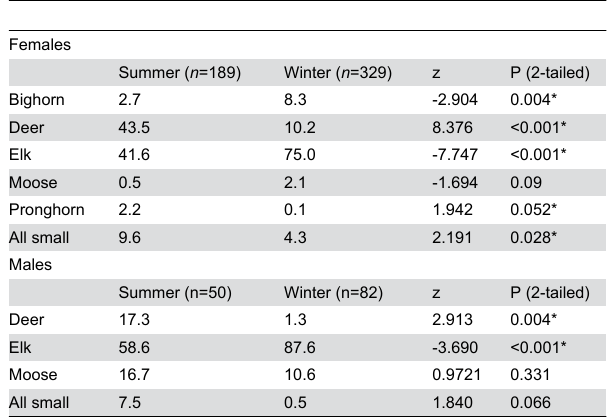
Table 3. A comparison of proportions (%) of different prey killed by female and male cougars in summer and winter, and the results of the two-proportions